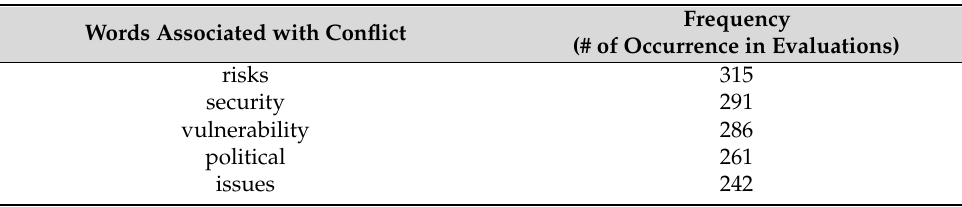
Table 2. Words frequently associated with conflict in climate change project evaluations resulting from NLP